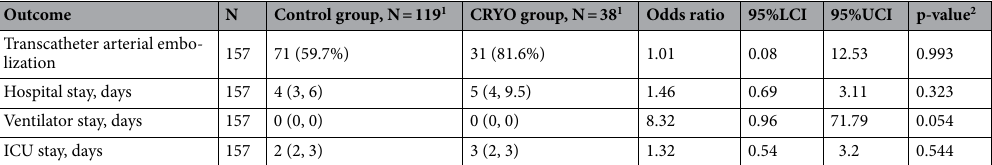
Table 3. Multivariable binary/proportional odds logistic analysis. CRYO, cryoprecipitate; ICU, intensive care unit. 1 Statistical data are presented as the median (interquartile range) or n (%). 2 Statistical tests performed: multivariable logistic regression; multivariable proportional odds logistic regression.